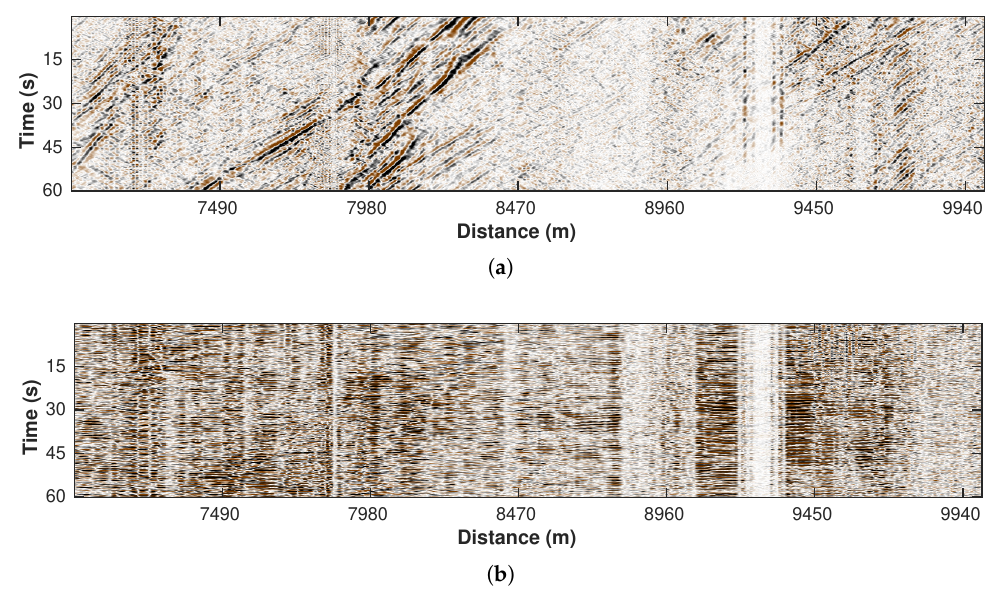
Figure 11. Processing results of local F-K filtering with sector cutting. ( a ) Filtered data. ( b ) Removed noise section.